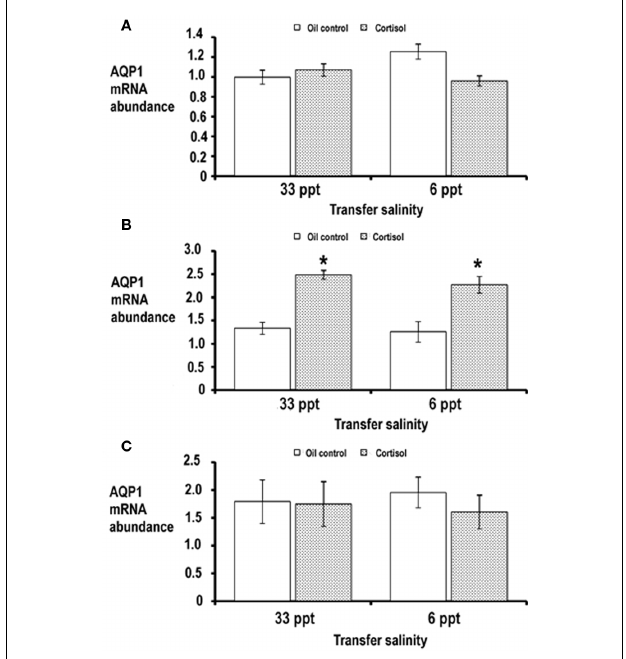
FIGURE 5 | Expression ofAQP1a in gill (A), intestine (B), and kidney (C) of silver sea bream following administration of oil alone (control) or cortisol and then transferred to either 33 or 6ppt salinity. Data is presented as normalized AQP1a transcript abundance (arbitrary units) and values are expressed as means ± SEM ( n = 7). An asterisk above a bar indicates values that were found to be different between oil and cortisol treated groups ( p <